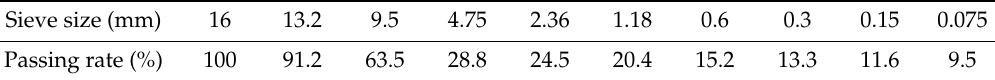
Table 6. Mineral aggregate gradation of the SMA-13 mixture.